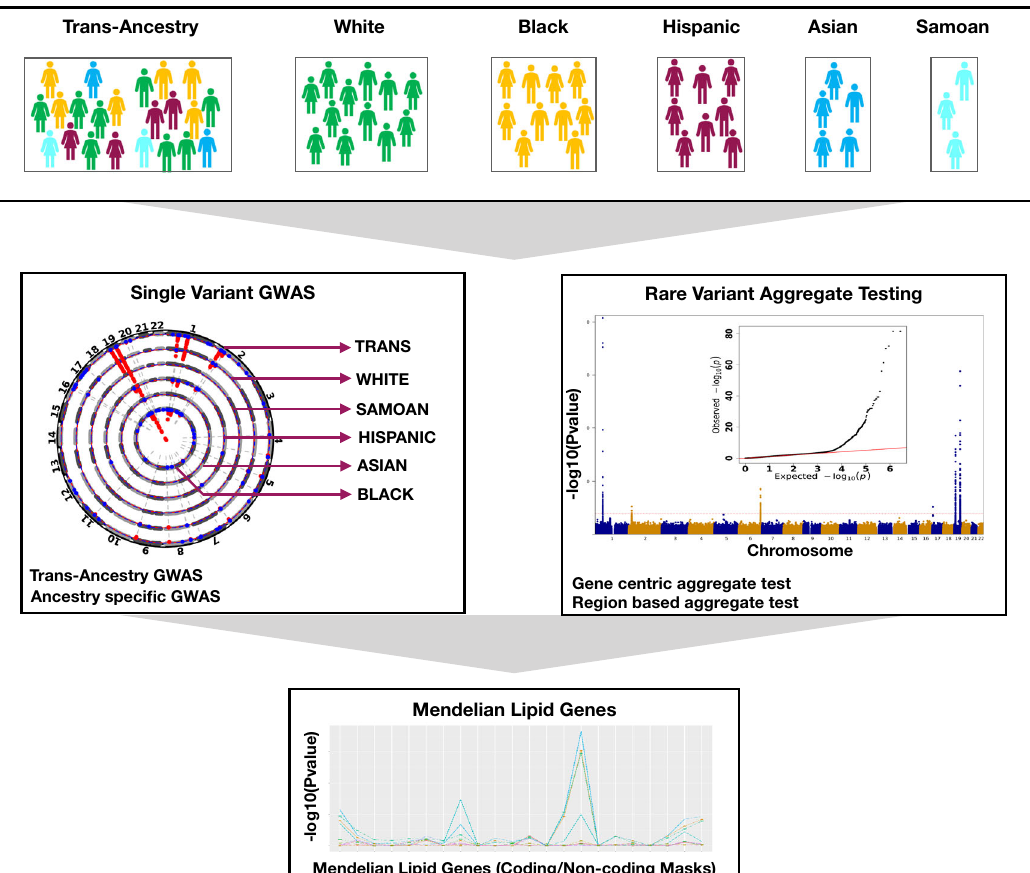
Fig. 1 | Overall study schematic. The analyses were conducted using the multi- ancestralTOPMedfreeze8datatoassociatewholegenomesequencevariationwith lipid phenotypes (i.e., LDL-C, HDL-C, TC, and TG). A total of 66,329 samples with lipidsquanti fi eddatafrom fi veancestrygroupswereanalyzed.SinglevariantGWAS were carried out using SAIGE on the Encore platform using SNPs with MAC >20. Both trans-ancestry and ancestry-speci fi c GWAS were conducted. Genome-wide rare variant (MAF <1%) gene-centric and region-based aggregate tests were